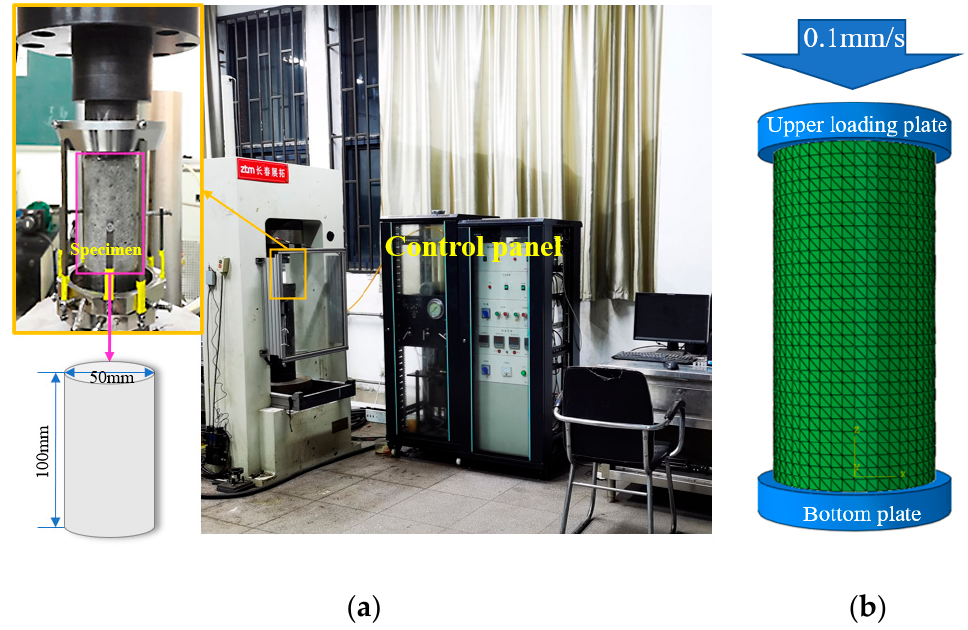
Figure 5. Uniaxial compression test: ( a ) laboratory experiment; and ( b ) numerical model.